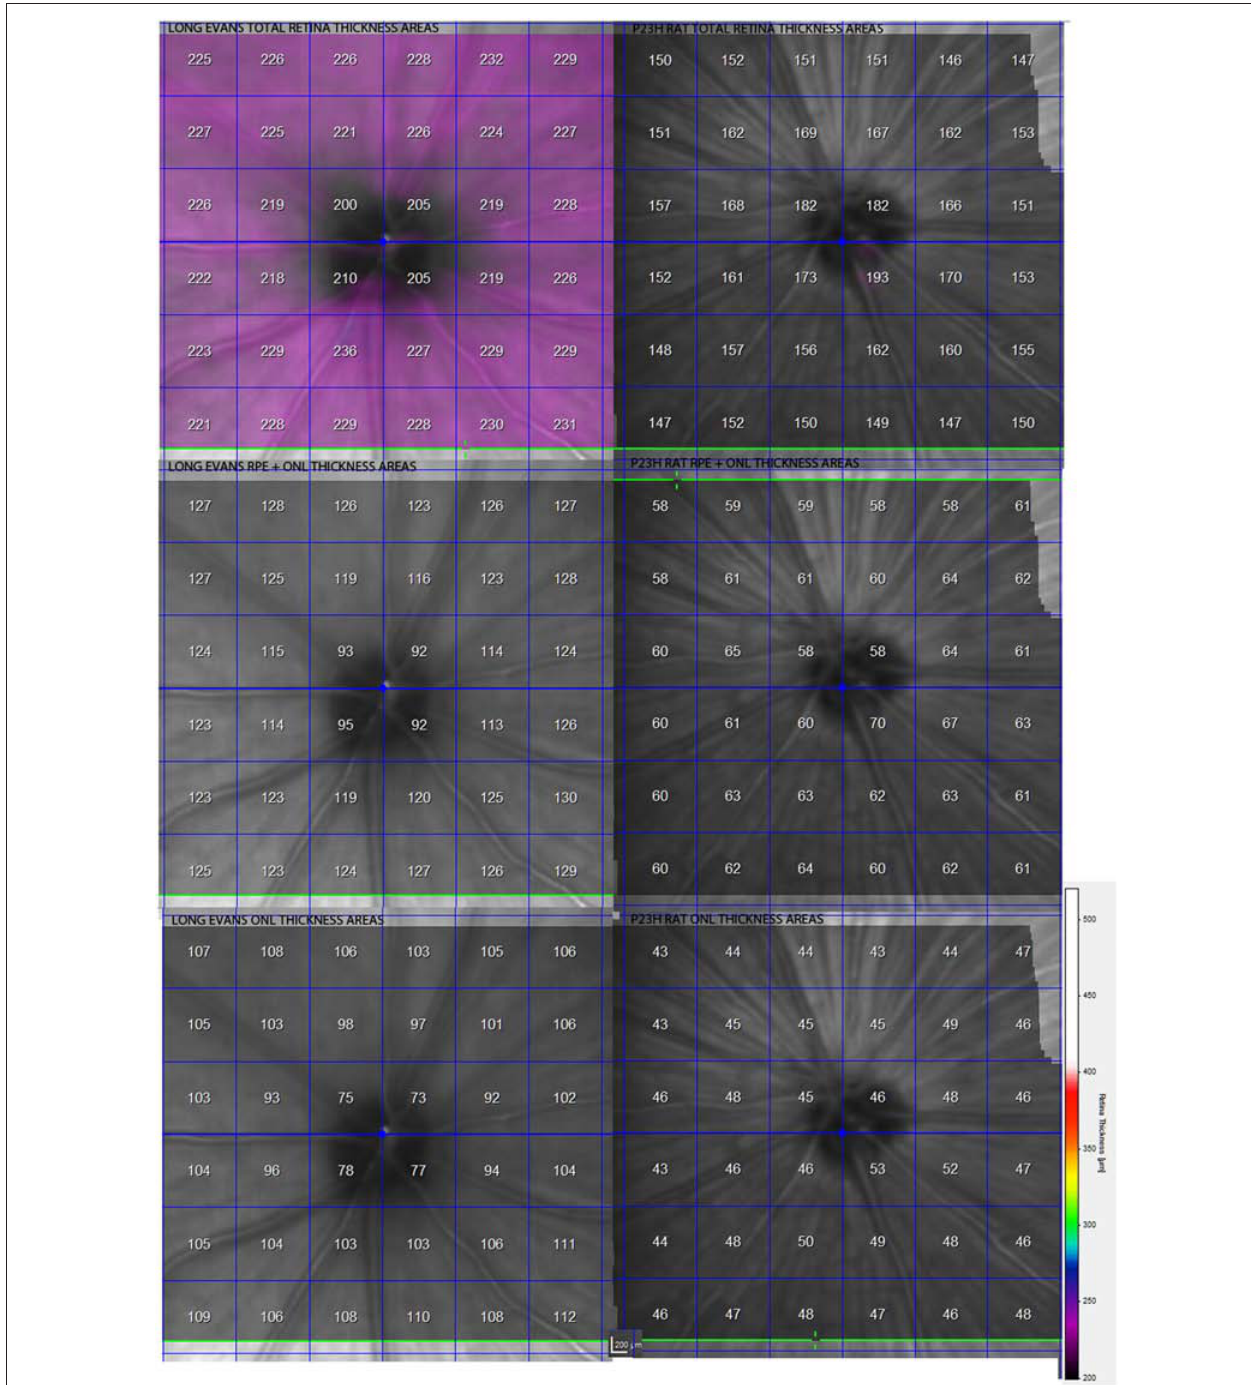
FIGURE 6 | Example of retinal maps of control and P23H pigmented line 1 rats at P130 . Mean retinal thickness value in microns is shown inside each square. Maps correspond to total retinal maps, RPE + ONL thickness and ONL thickness. All values were statistically lower in P23H rats.